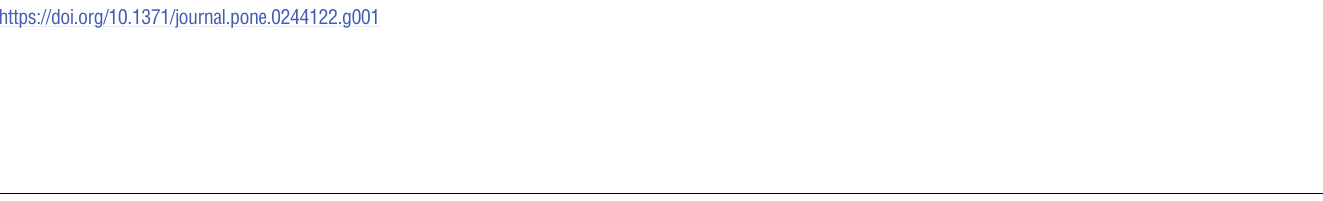
PLOS ONE | https://doi.org/10.1371/journal.pone.0244122 May 10,